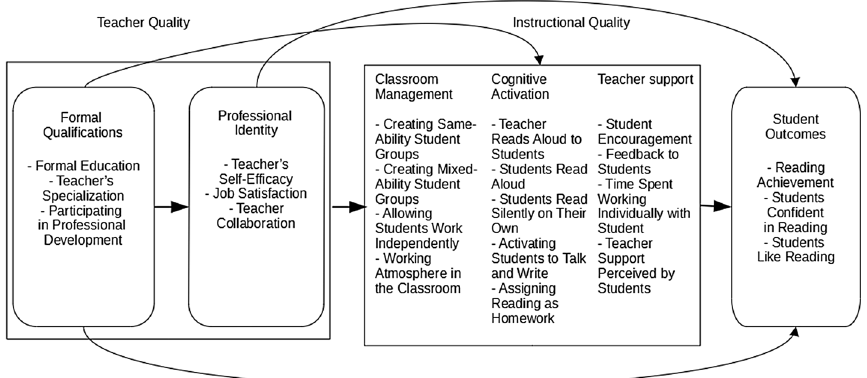
Fig. 1 General structure of path analysis